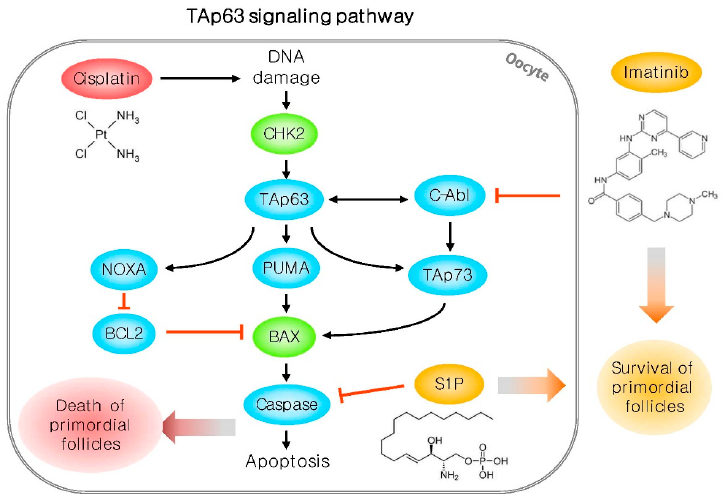
Figure 1. Schematic model for chemotherapy-induced oocyte death via the TAp63 signaling pathway. Cisplatin treatment causes DNA damage in oocytes and induces a surveillance factor, Chk2, followed by activation of NOXA, PUMA, and TAp73. Therefore, DNA-damaged oocytes undergo programmed cell death. However, imatinib and S1P rescue these DNA-damaged oocytes via inactivation of the TAp63 signaling pathway. Black arrow: activation; red T bar: suppression.